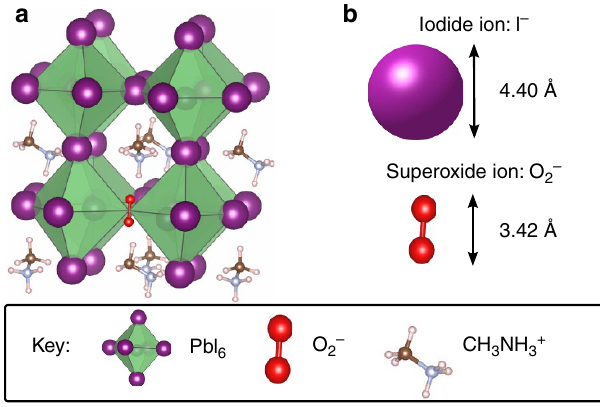
Figure 6 | Size comparison of superoxide and iodide anions. Atomic structure of CH 3 NH 3 PbI 3 showing ( a ) superoxide ion, O 2 (cid:2) , occupying an iodide vacancy, V x (for clarity, a pseudo-cubic sub-region of the structure is I shown and not the full tetragonal supercell used in the calculations). ( b ) Comparison of relative size of iodide and superoxide anions (using ionic radius of I (cid:2) and, for the superoxide ion, interpolation between covalent radius in O 2 and ionic radius of O 2 (cid:2) ).